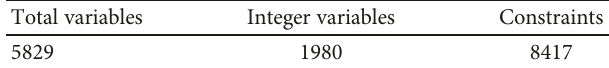
Table 4: Scale of the empirical case